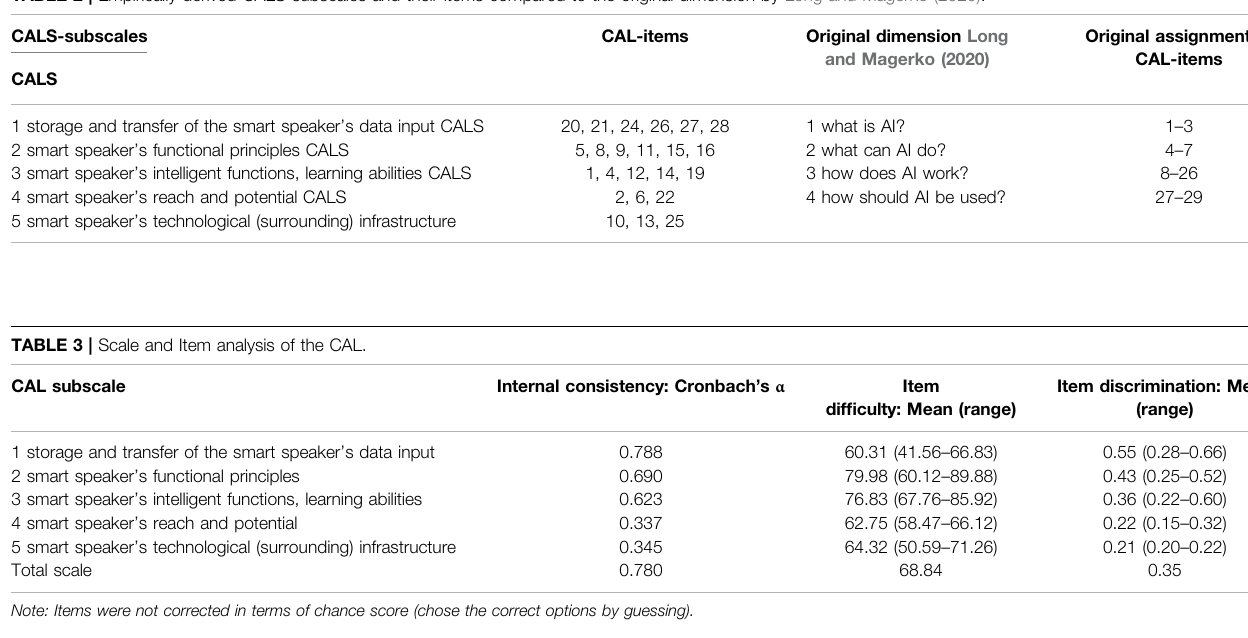
TABLE 4 | Intercorrelations of the CALS